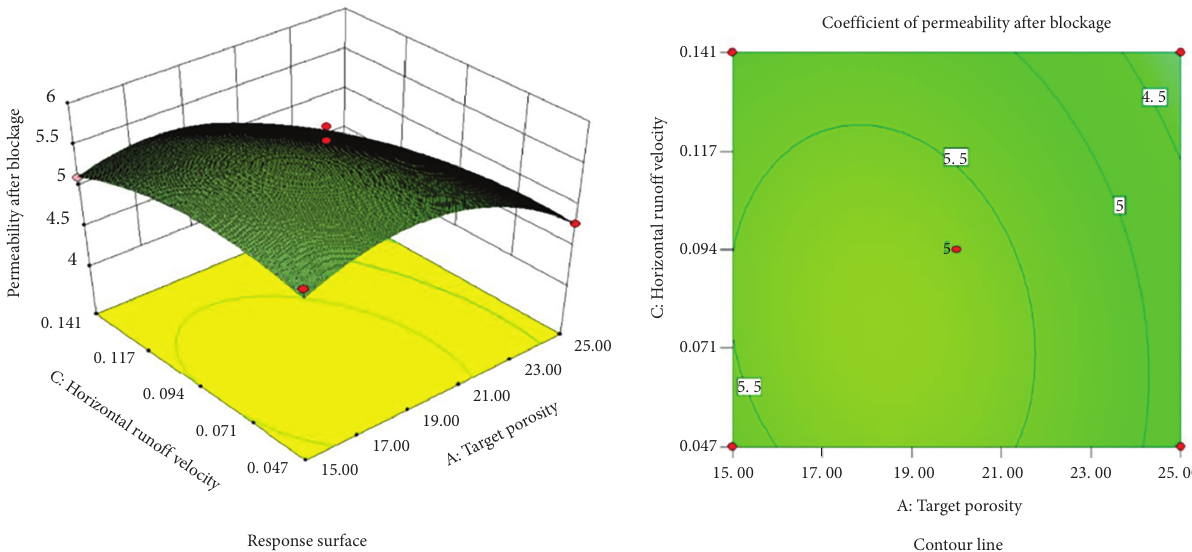
Figure 12: Target porosity A and horizontal runoff velocity C affect the permeability coefficient after